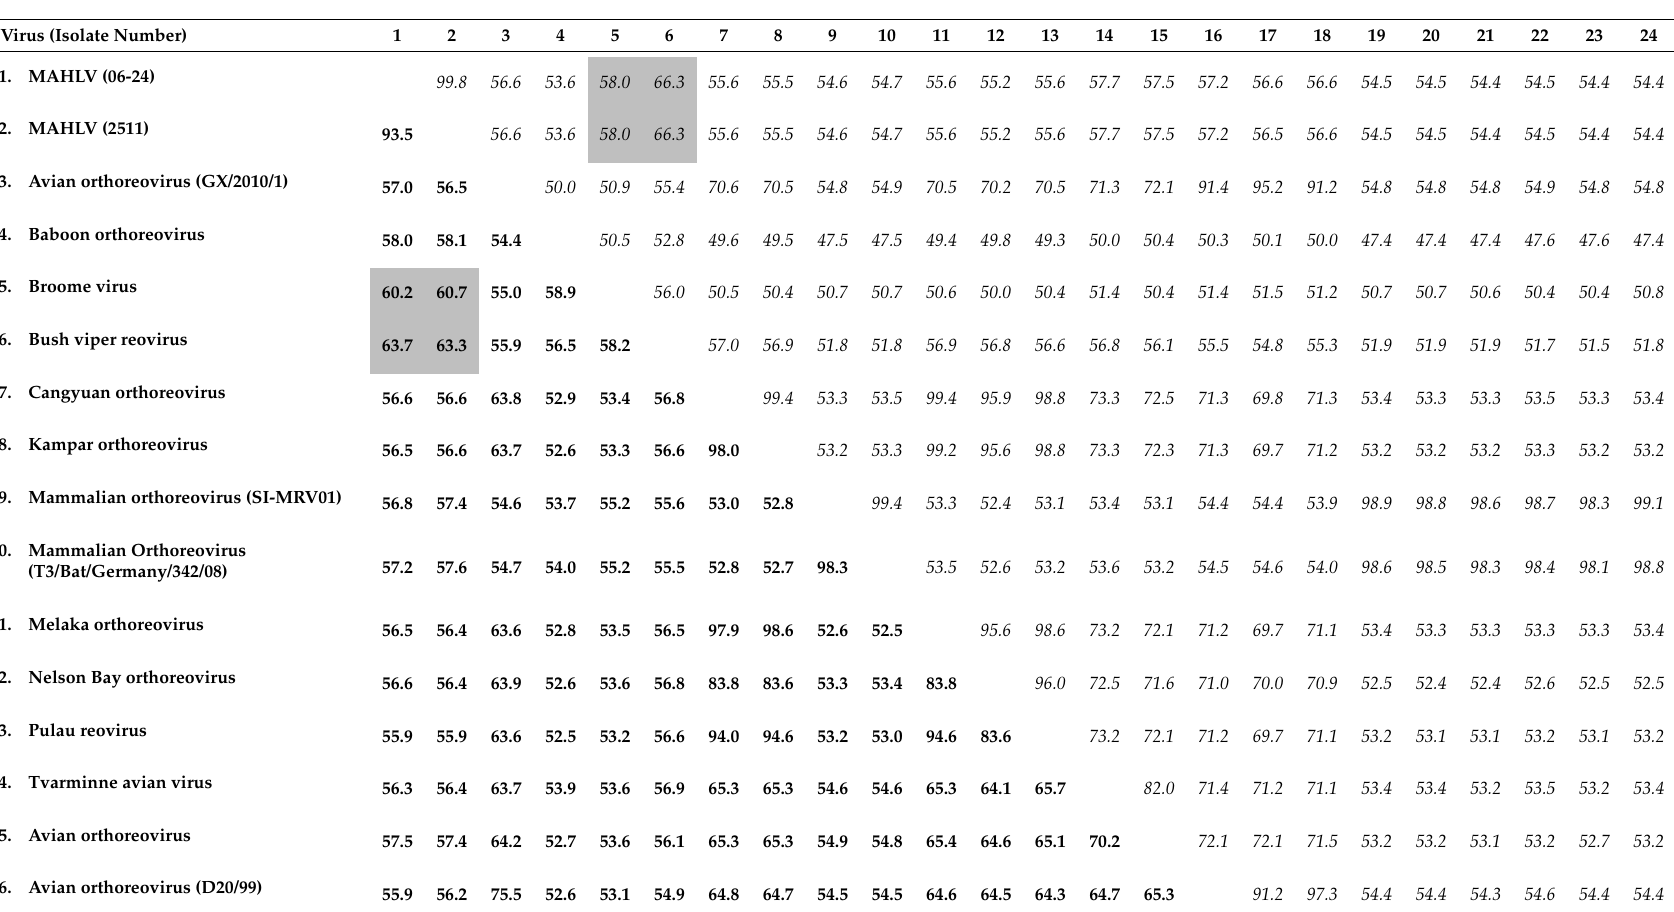
Table 2. Identity values (%) of the RNA dependent RNA polymerase encoding segments and deduced amino acid sequences of MAHLV and other orthoreoviruses. Nucleic acid sequences are in the bottom left triangle and in bold text, and deduced amino acid sequences are in the top right triangle in italics. The grey shaded areas indicate the identity values of the closest related virus(es) to